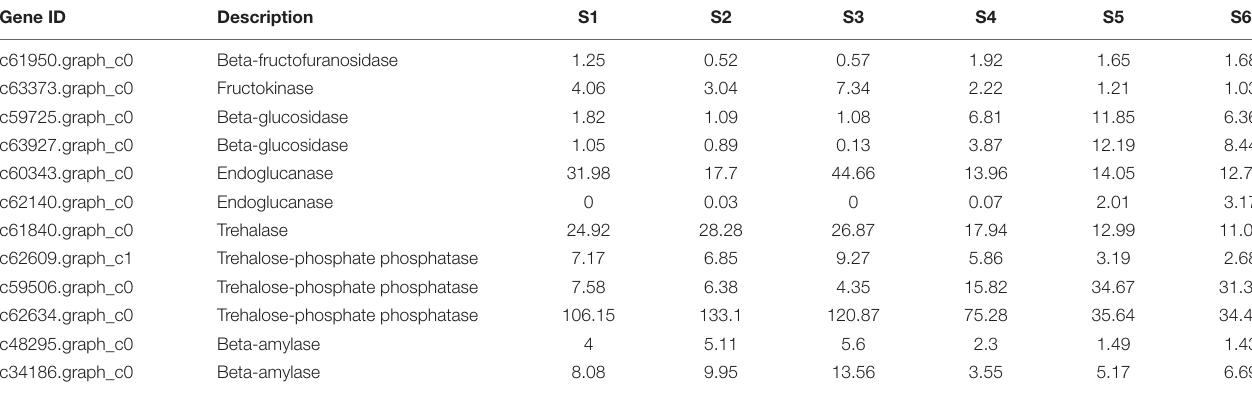
TABLE 2 | Homologous sequences of DEUs involved in starch and sucrose metabolism during six growth and developmental stages of C . sinense